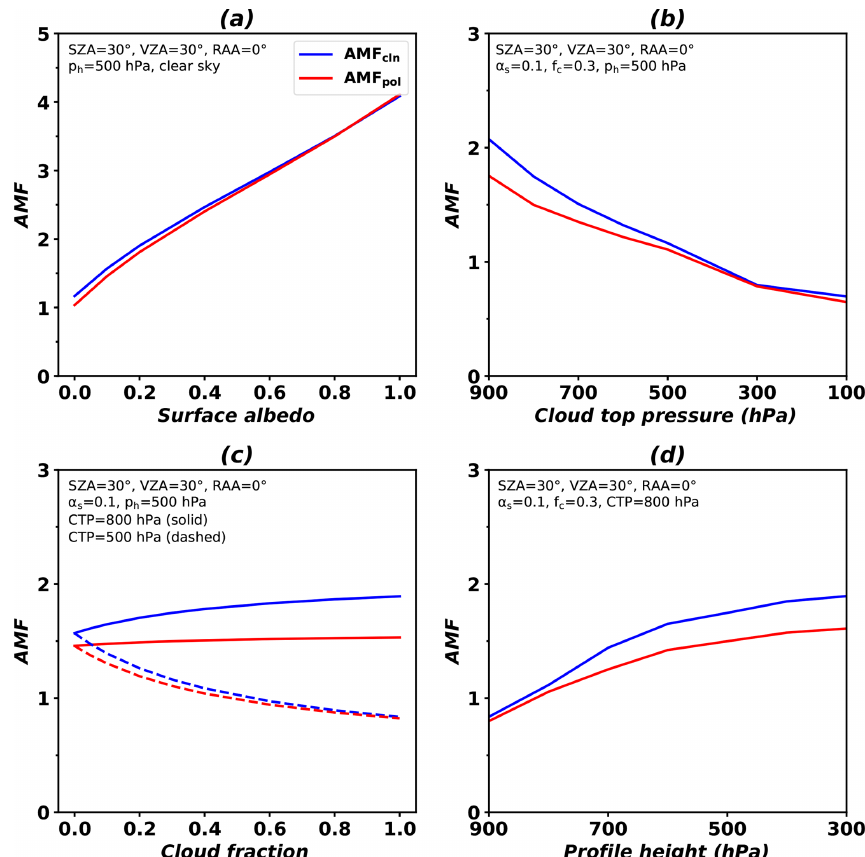
Figure 5. AMF variations as functions of (a) surface albedo, (b) cloud top pressure (CTP), (c) effective cloud fraction ( f c ), and (d) profile height over clean (blue) and polluted (red) areas. Conditions of the AMF LUT are given in the figures. For sensitivity to surface albedo, cloud-free conditions are assumed. For sensitivity to cloud fraction, cloud top pressures are 800hPa (solid line) and 500hPa (dashed line).